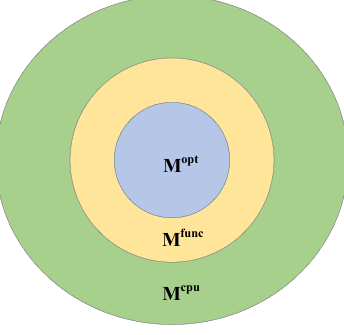
Figure 8. The structure of the SFG of the